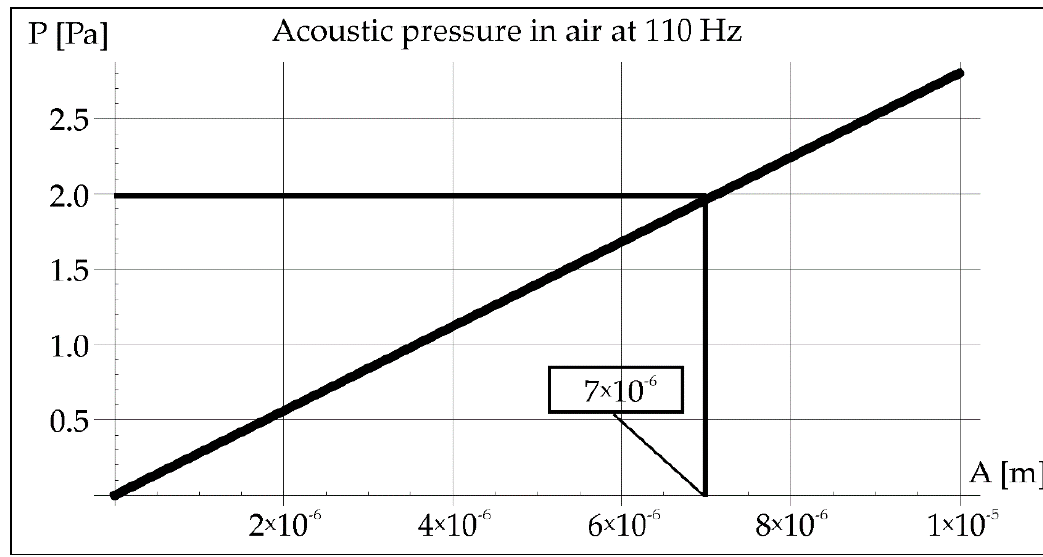
Figure 8. Acoustic pressure in air at resonance frequency 110 Hz.